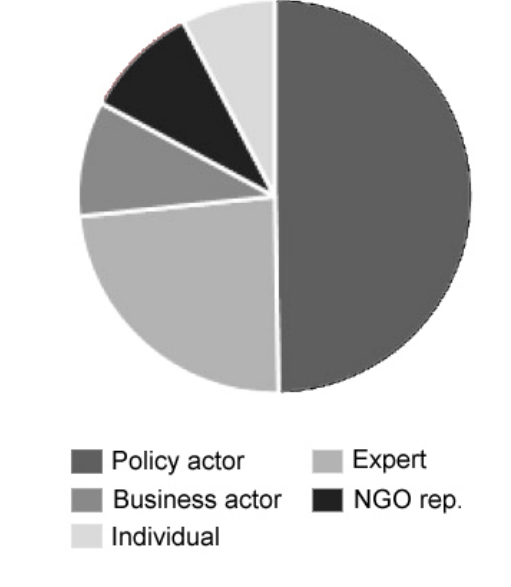
Fig. 1 . Pie graph to show the proportion of actor types involved in the